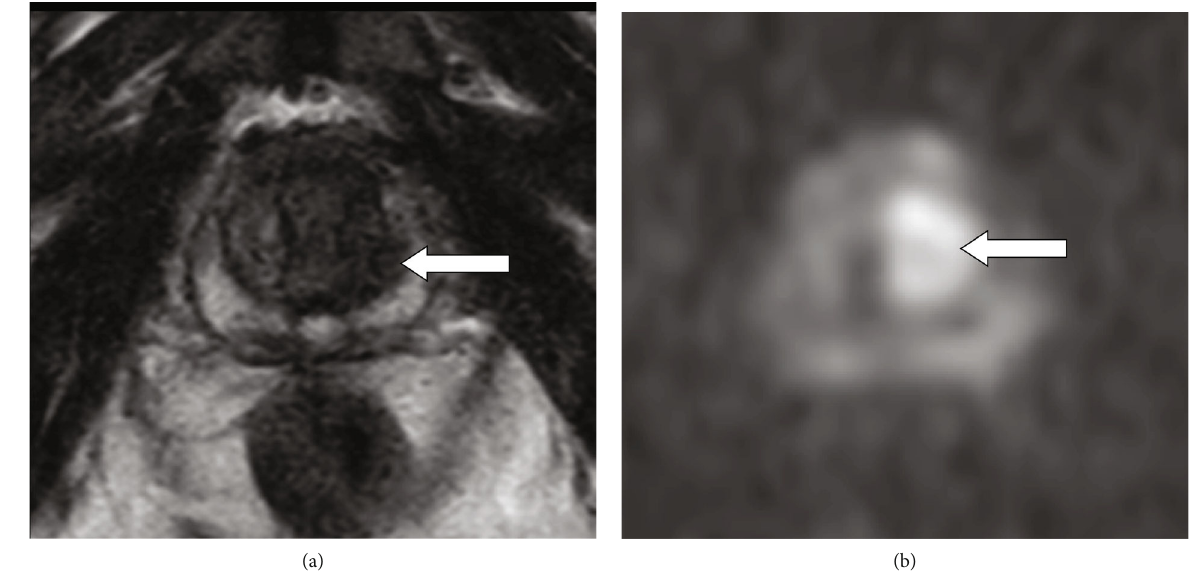
Figure 1: (a) Magnetic resonance imaging showed a low-intensity area in the T2-weighted image (white arrow). (b) A high-intensity area in the di ff usion-weighted image at the left transition zone (white arrow).